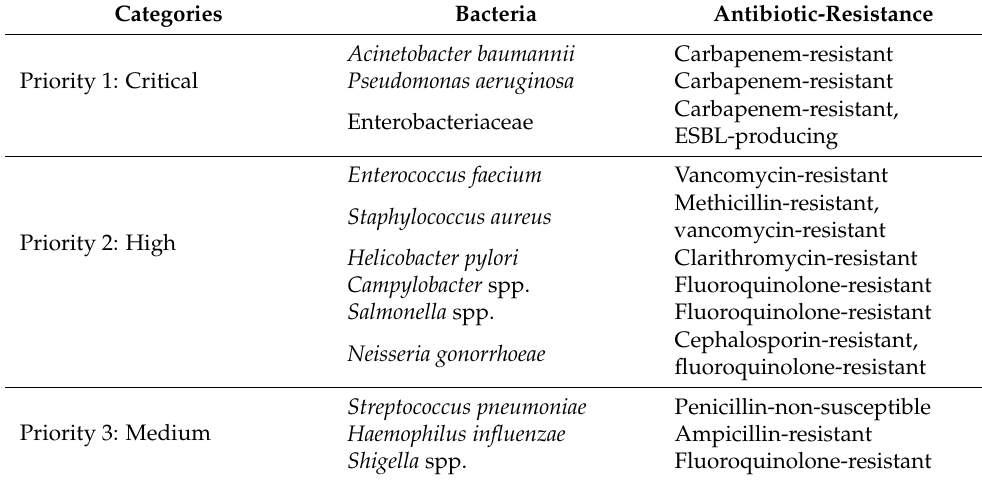
Table 1. WHO priority pathogens